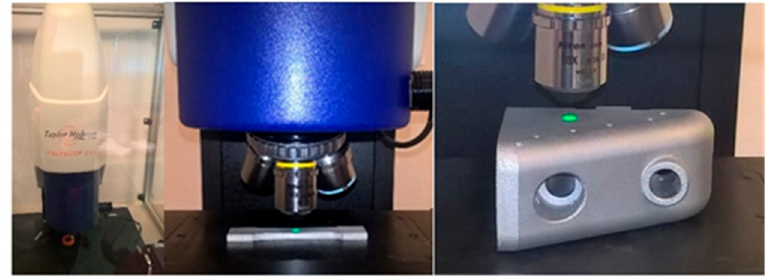
Figure 3. Talysurf CCI Lite—optical profilometer, samples during measurements.